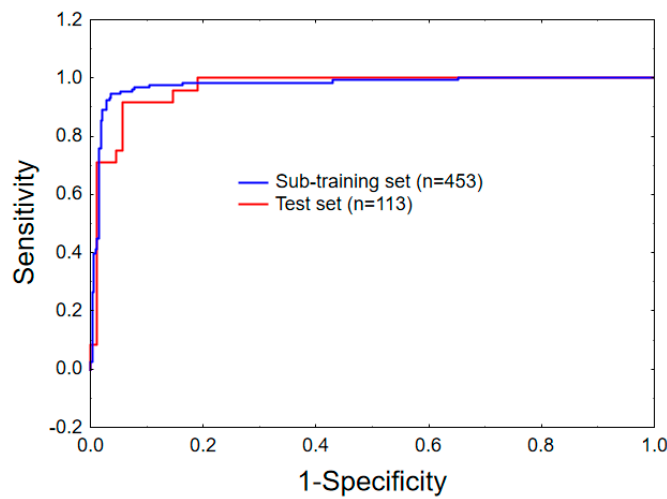
Figure 1. Receiver operating characteristic (ROC) curves for the sub-training (10-fold) and the test sets.